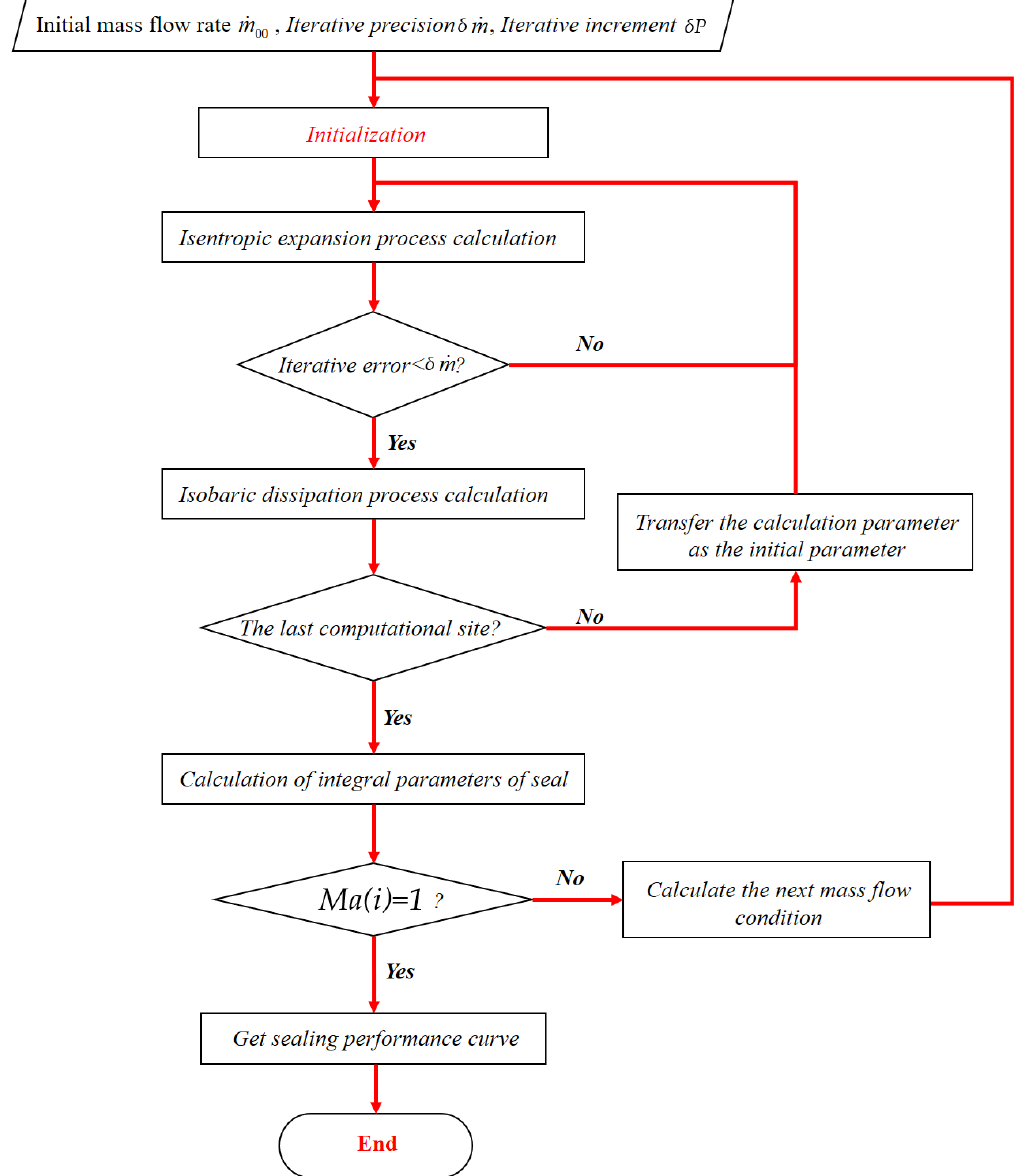
Figure 4. Block diagram of one-dimensional(1-D) computation process of labyrinth seal.